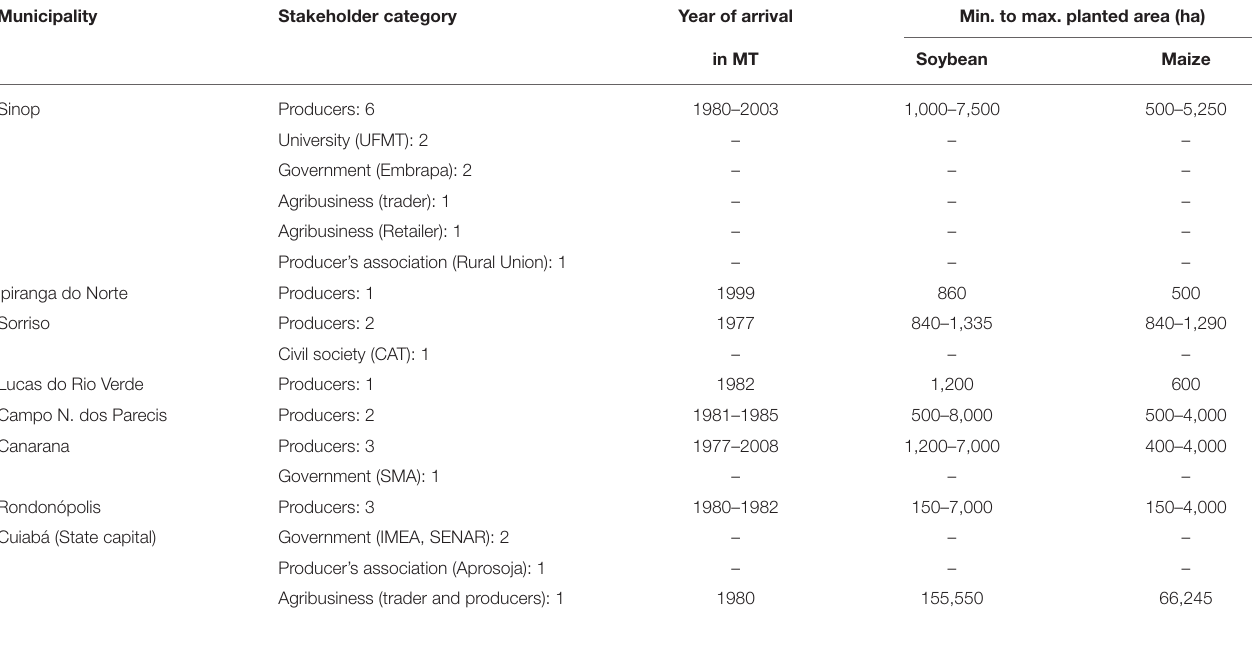
TABLE 1 | List of stakeholders interviewed during fieldwork in Mato Grosso State, Brazil, in